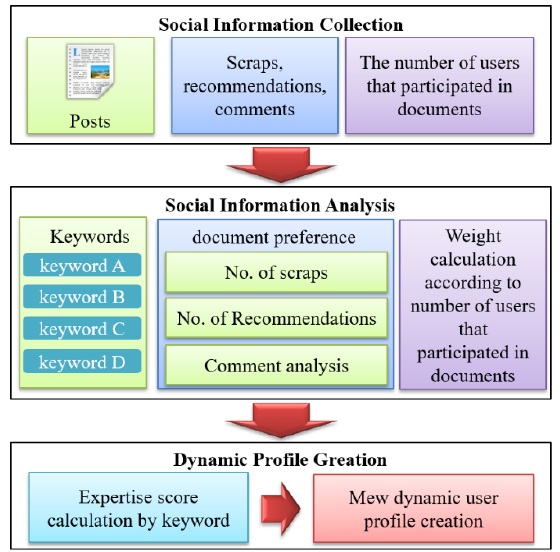
Figure 3. Social activity analysis process.